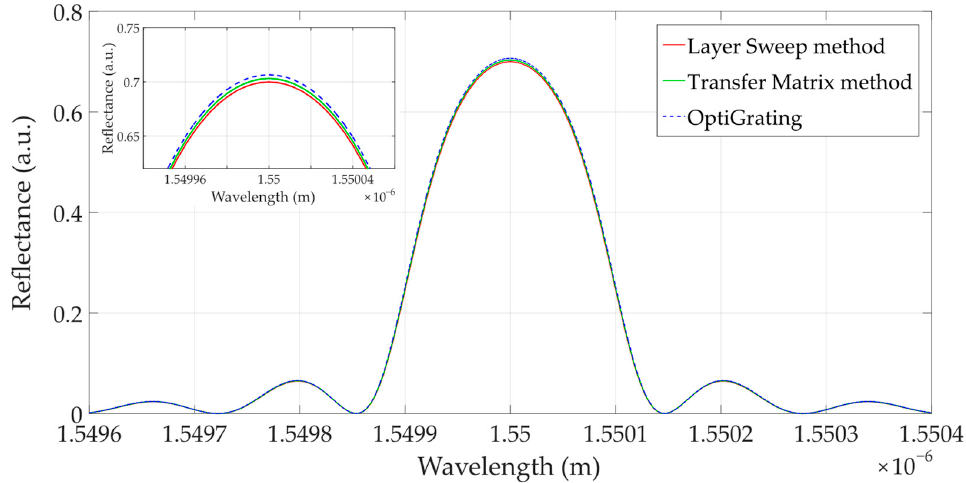
Figure 4. Simulated spectra of the homogeneous FBG obtained using the Layer Sweep method (red solid line), Transfer Matrix method (green solid line), OptiGrating software (blue dotted line), and amplified spectra near the reflectance peak (insert).